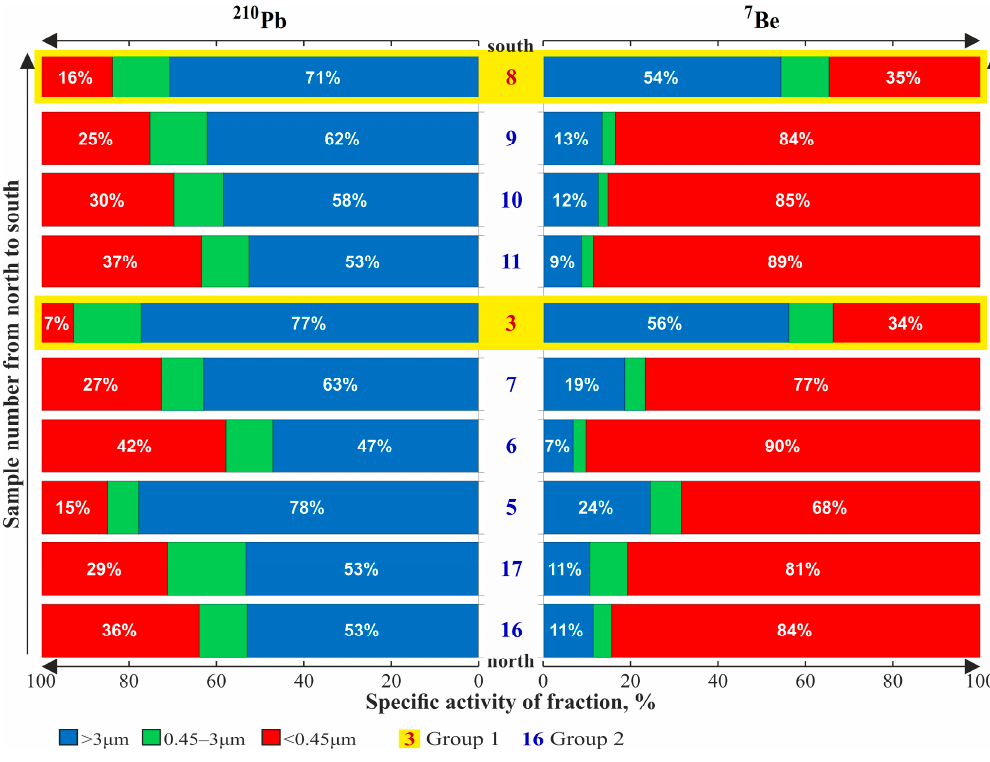
Figure 10. The contribution of particulate fractions (%) of suspended matter in snow water to the total activity of 210 Pb atm and 7 Be, sampled from north to south in the territory of YNAD.